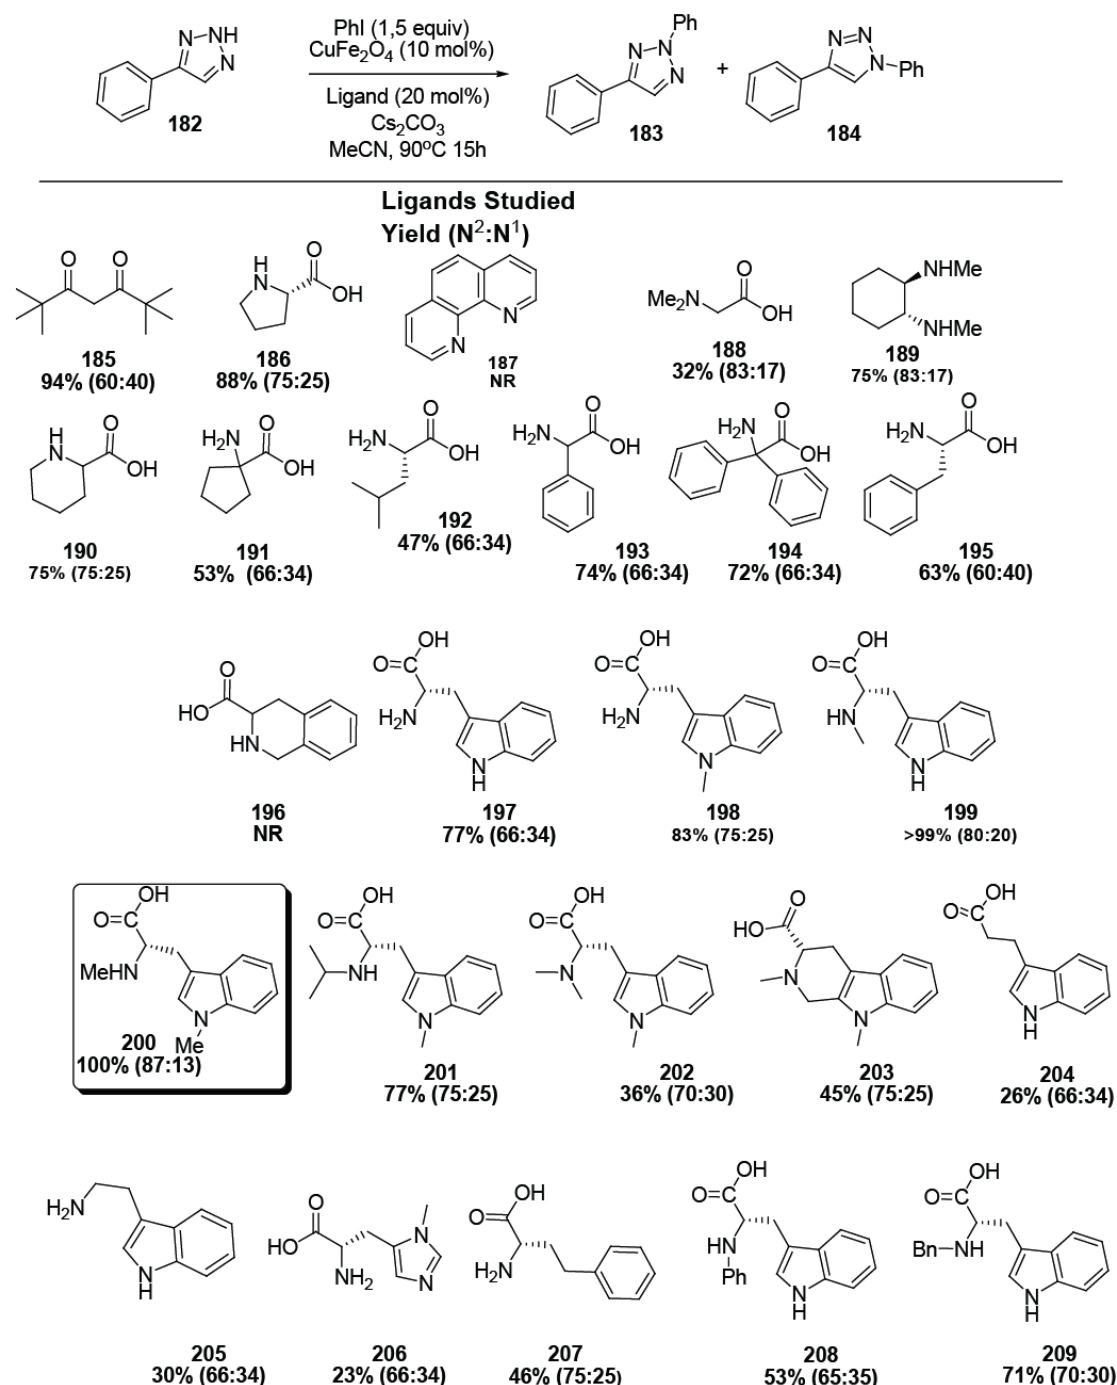
Figure 25 - Data on the yield and regioselectivity of different class of ligands for the copper catalyzed N2-Regioselective arylation of